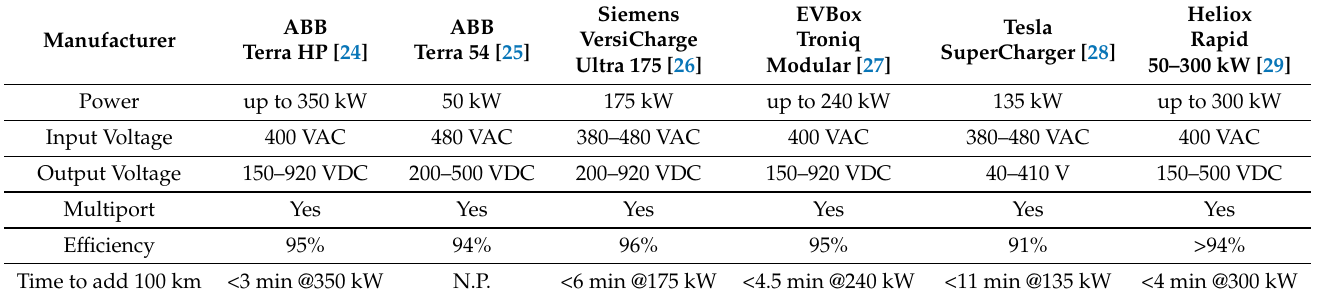
Table 1. State-of-the-art DC fast charging solutions in the industry (NP: not